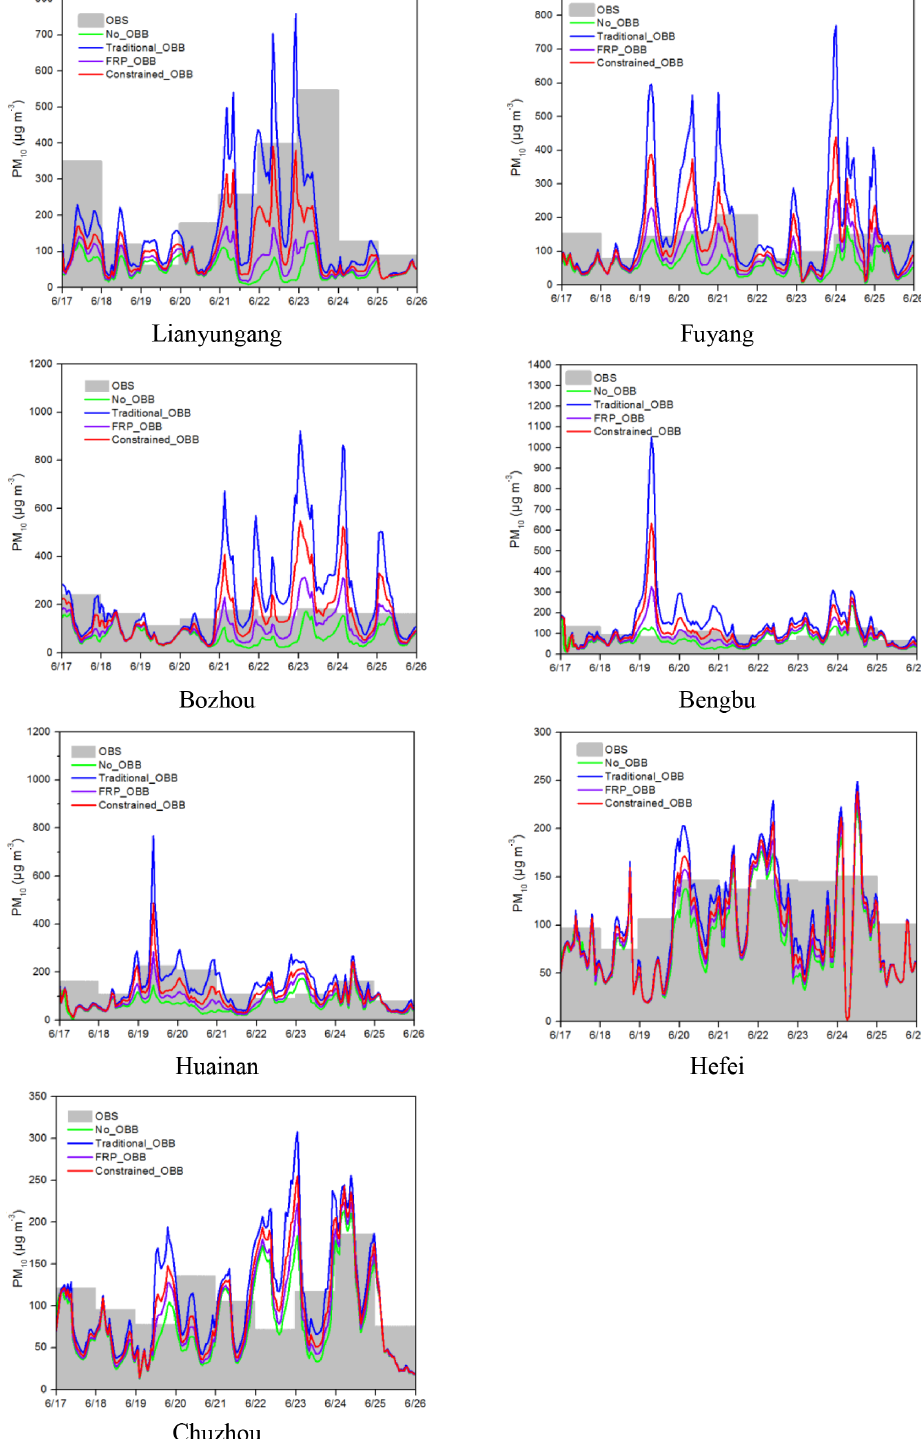
Figure 4. Observed 24h averaged PM 10 concentrations and simulated hourly PM 10 concentrations without OBB emissions (No_OBB) and with OBB emissions based on traditional bottom-up (Traditional_OBB), FRP-based (FRP_OBB) and constraining (Constrained_OBB) methods in Lianyungang, Fuyang, Bozhou, Bengbu, Huainan, Hefei and Chuzhou during 17–25 June 2010.